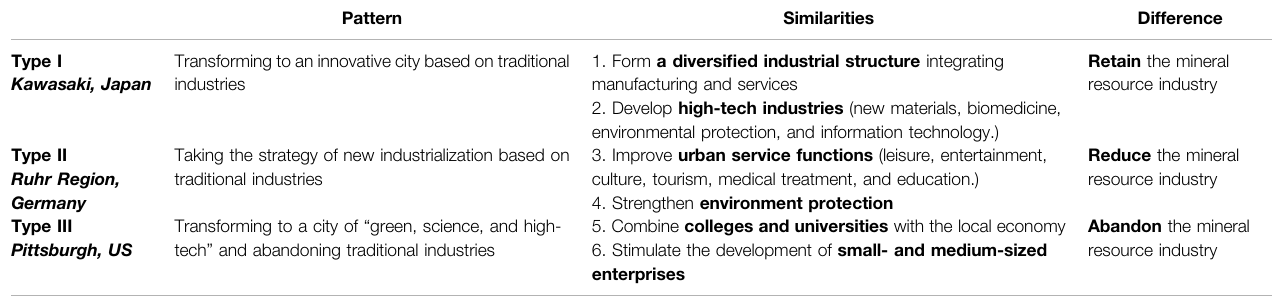
TABLE 1 | Three patterns of transformation of mineral resource-based cities.